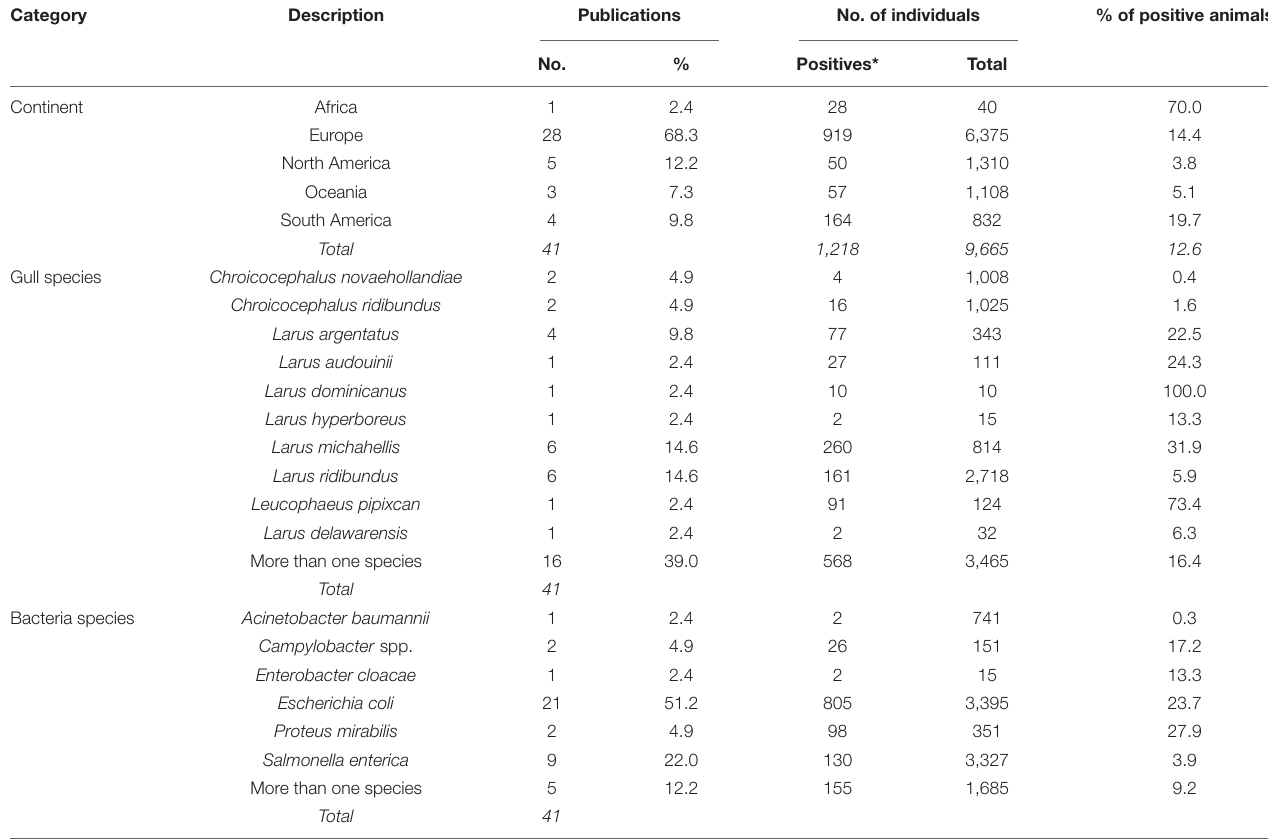
TABLE 1 | AMR bacteria detected in gulls by continent and gull species between 1981 and 2020. Category